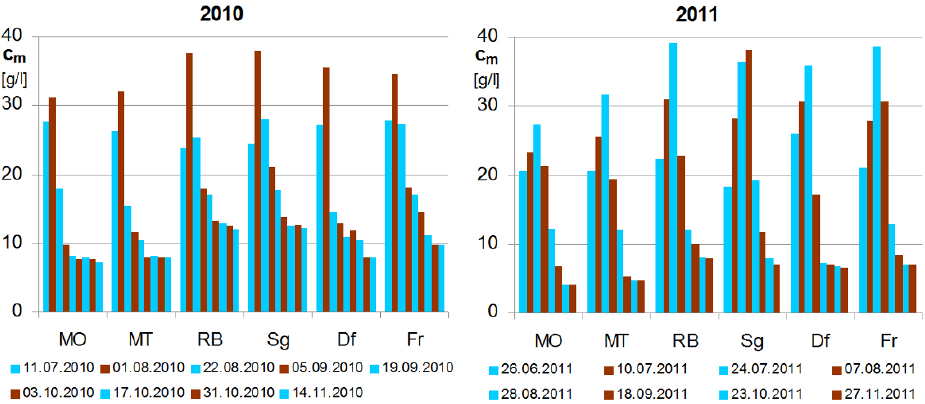
Figure 3. Comparison of titratable acidity changes in grapes of individual varieties in 2010 and 2011: Muscat Ottonel (MO), Müller-Thurgau (MT), Pinot Blanc (RB), Sauvignon (Sg), Dornfelder (Df), and blue Frankish